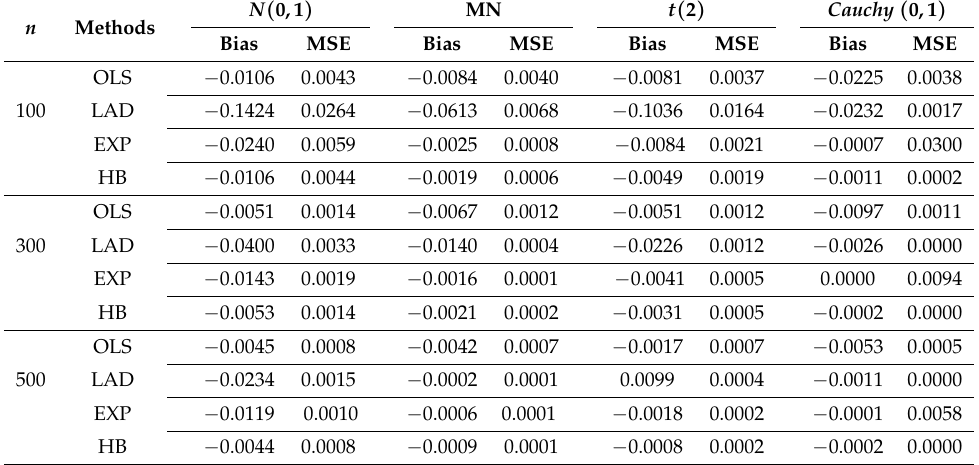
Figure 1. ( a ) The sample mean of IMSE for functional parameters β ( t ) and g ( z ) when n = 500 and π takes values in the set { 0.1,0.2,0.3,0.4,0.5,0.6,0.7,0.8,0.9 } ; ( b ) the sample mean of MSE ( × 10 3 ) for autoregressive coefficient a under the same setting. Table 1. The Bias and MSE of ˆ a under different error distributions.